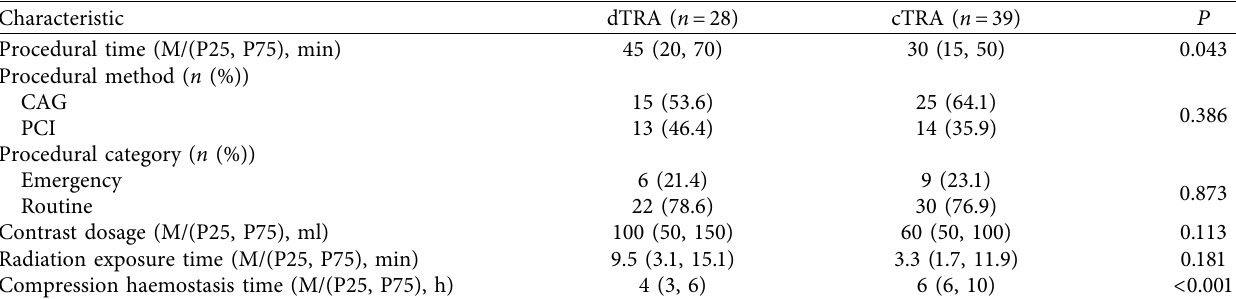
Figure 3: (a) The puncture success rate, (b) the one-needle puncture success rate, and (c) the puncture time between the two groups. Table 2: Comparison of the efficacy between the two